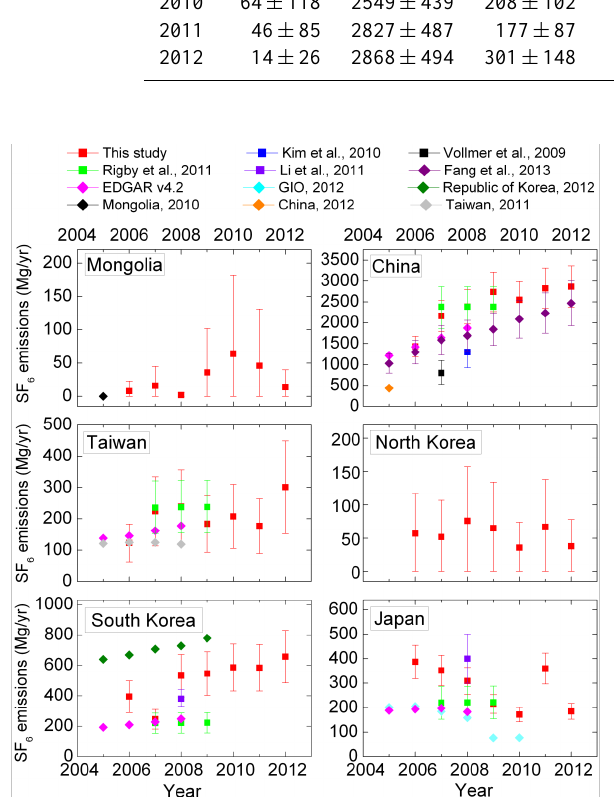
Fig. 6. Comparison of our a posteriori national emission estimates with other published estimates, as specified in the legend at the top. Square symbols denote top-down estimates and diamond symbols denote bottom-up estimates.